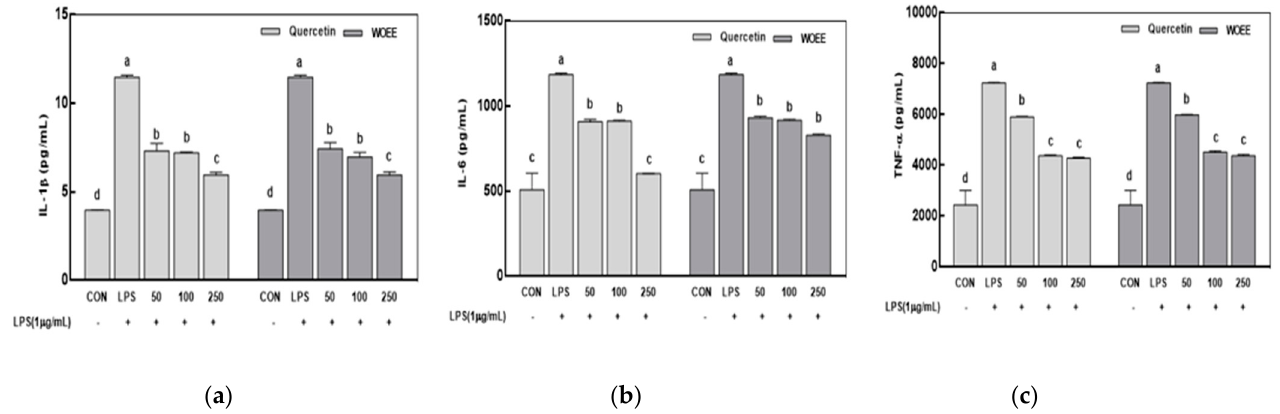
Figure 4. Anti-inflammatory effects of quercetin and WOEE on LPS-stimulated RAW 264.7 macrophages. ( a ) IL-1β, ( b ) IL-6, and ( c ) TNF-α levels (pg/mL) in the supernatant. The data were analyzed by one-way ANOVA using SPSS software and each bar presents the mean ± SE. (n = 3). a–d Mean values with different letters are significantly different ( p < 0.05) among groups, determined by Duncan’s multiple rage test.